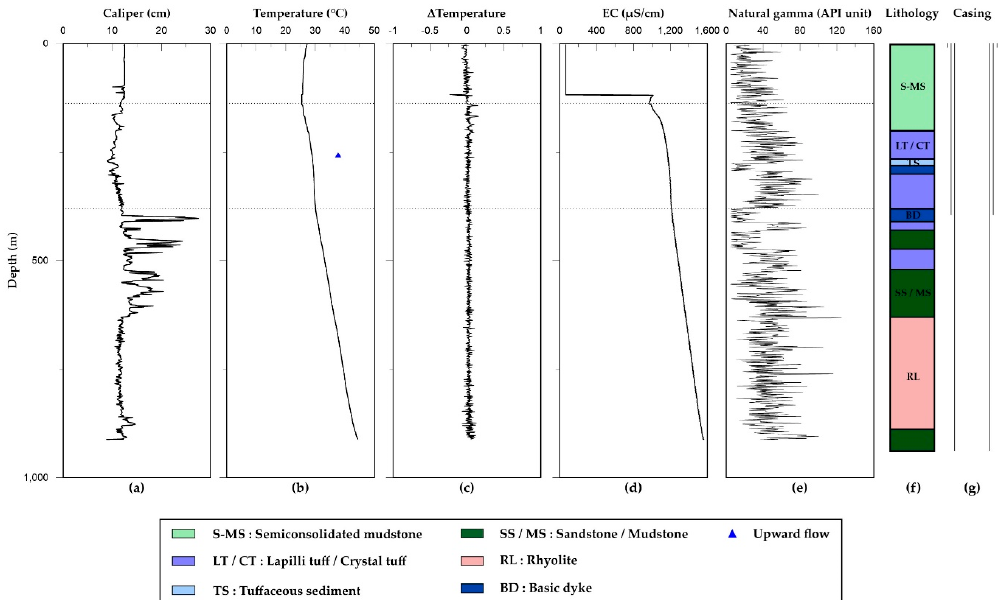
Figure 7. Geophysical and lithological profiles of BH-3: ( a ) Caliper log; ( b ) temperature log; ( c ) delta temperature log; ( d ) electrical conductivity (EC) log; ( e ) natural gamma-ray log; ( f ) a simplified lithological log; and ( g ) a casing installation. The blue triangle indicates upward ground flow. Estimated depth intervals where groundwater flows occurred are marked with dotted lines. Appl. Sci. 2020 , 10 , x FOR PEER REVIEW